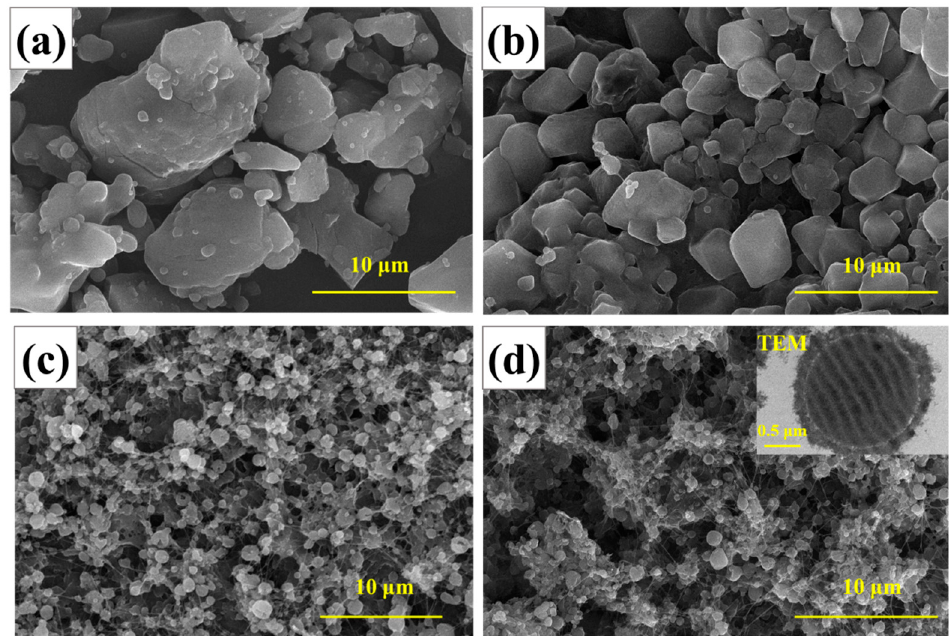
Figure 4. SEM images of raw RDX and RDX@PVDF microspheres: ( a ) raw RDX; ( b ) RDX@PVDF (5:1); ( c ) RDX@PVDF (4:1); and ( d ) RDX@PVDF (3:1).